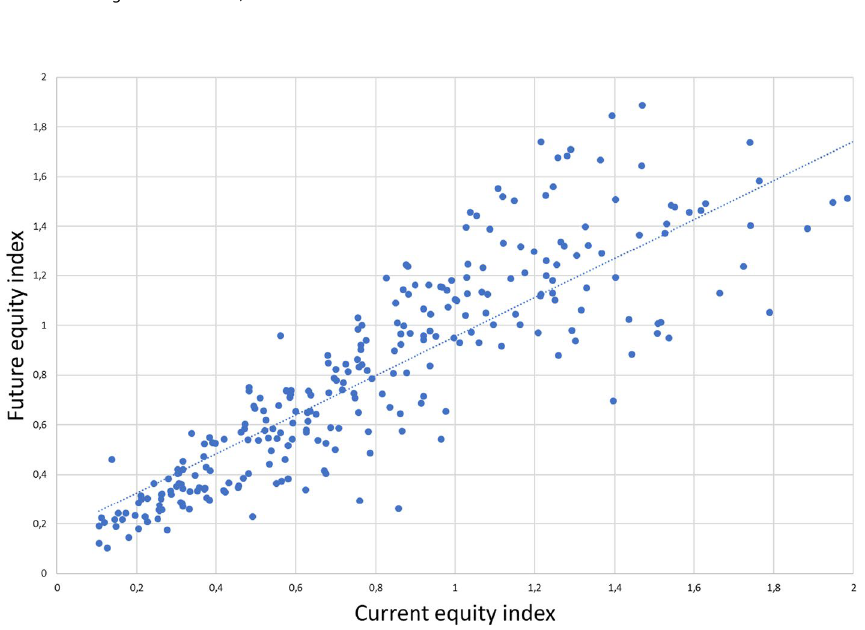
Source : INE 2019 agricultural census, GPP and authors’ calculations